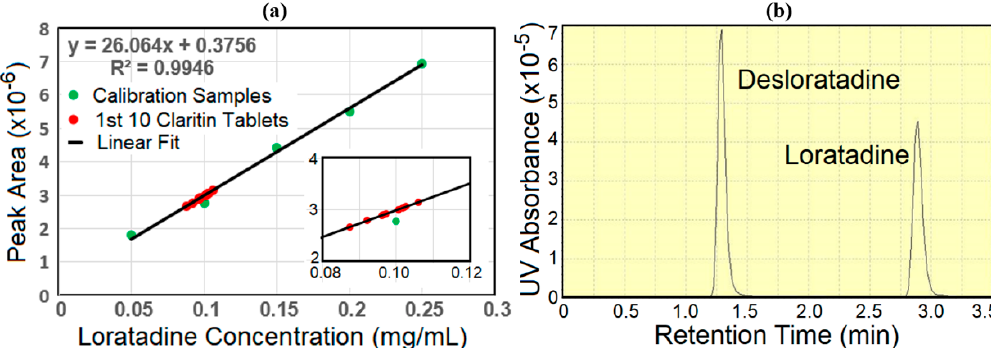
Figure 3. ( a ) HPLC-generated concentration curve for loratadine with calculated concentrations for the 1st 10 Claritin tablets (inset-expanded view of 10 tablets). ( b ) Example chromatograph with desloratadine and Claritin tablet elution peaks. Desloratadine and loratadine peak areas are 2,747,919 and 2,483,413, respectively.